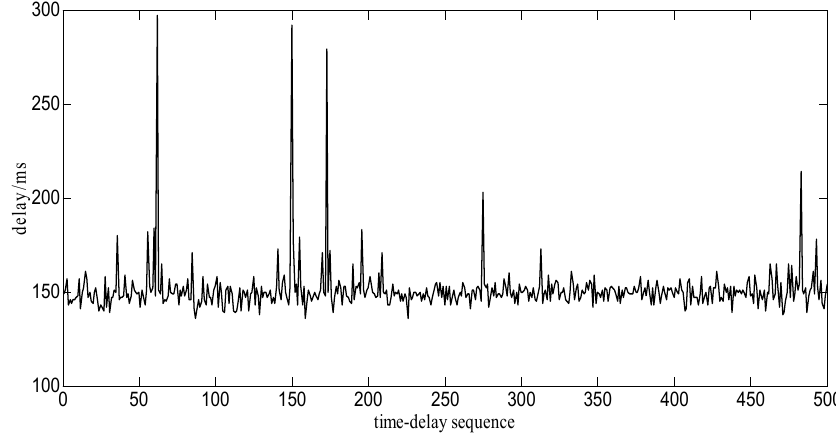
Figure 2. Typical random time delay of a